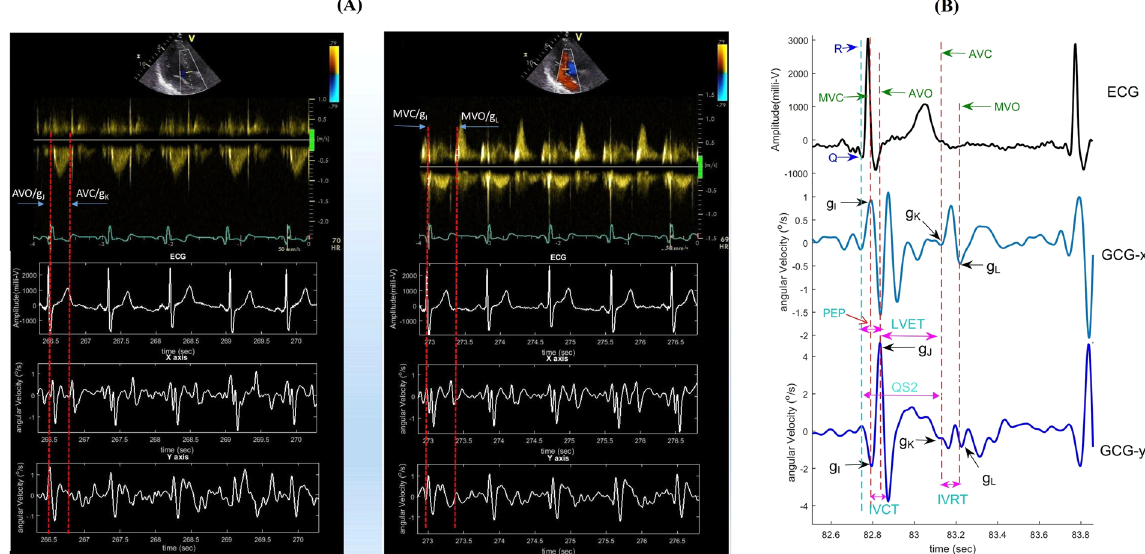
Figure 3. Waveform annotation and cardiac time interval estimation in GCG signal. Aortic (left) and mitral (right) valve opening and closure moments as measured by PW Doppler and correspondingly in GCG signal ( A ). Waveform annotation in GCG and corresponding time intervals with respect to ECG peaks ( B